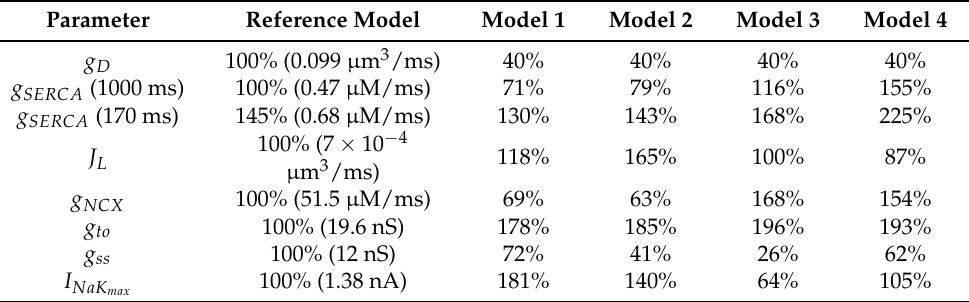
Table 1. Parameter values in four selected model samples, shown as percentages of the reference values at a BCL of 1000 ms from the Gattoni2016 cellular model